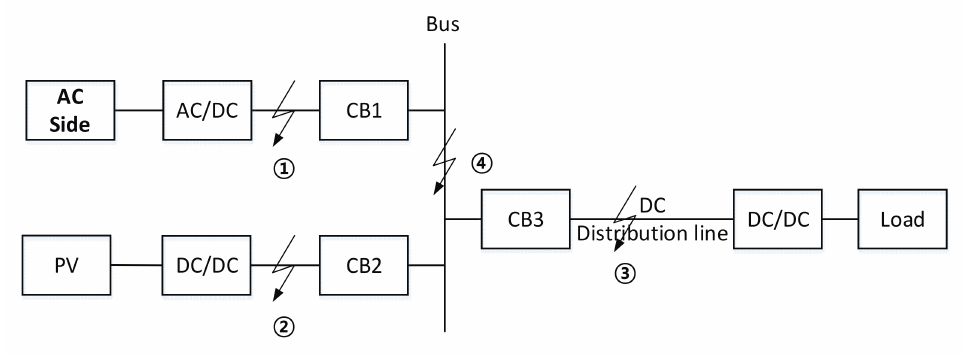
Figure 1. Configuration of an LVDC